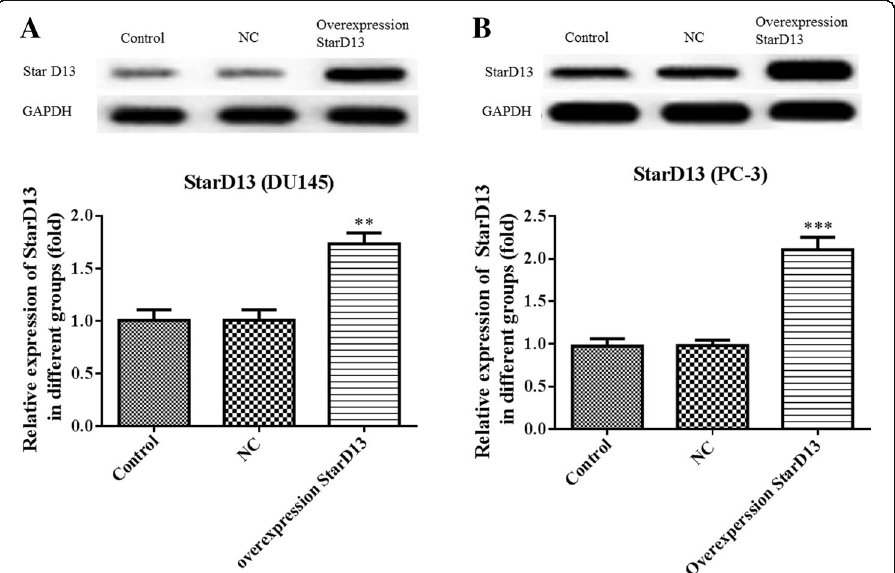
Fig. 6 The protein expression level of StarD13 in DU145 cells and PC-3 cells transfected with pcDNA3.1 plasmid. The expression levels in DU145 cells ( a ) and PC-3 cells ( b ) were determined via western blot. ** p < 0.01; *** p < 0.001 vs. NC group. All experiments were performed with at least